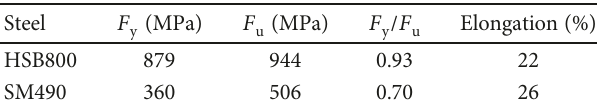
Table 3: Mechanical properties of steel.